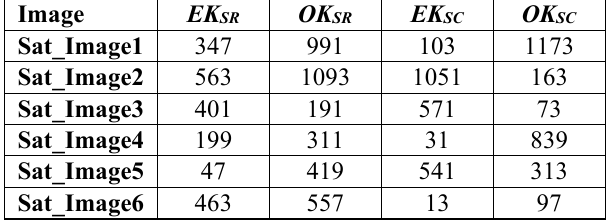
Table 1. Keyset for double transposition cipher